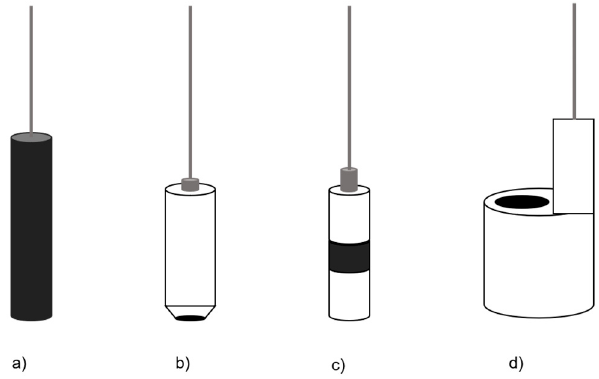
Figure 2. Different anode designs: ( a ) rod anode, when immersed 10 mm in melt gives a geometric surface area of approx. 3.9 cm 2 , ( b ) horizontal anode, anode surface area 0.79 cm 2 , ( c ) vertical anode, anode surface area 1.57 cm 2 , ( d ) inverted horizontal anode, anode surface area 0.69 cm 2 .